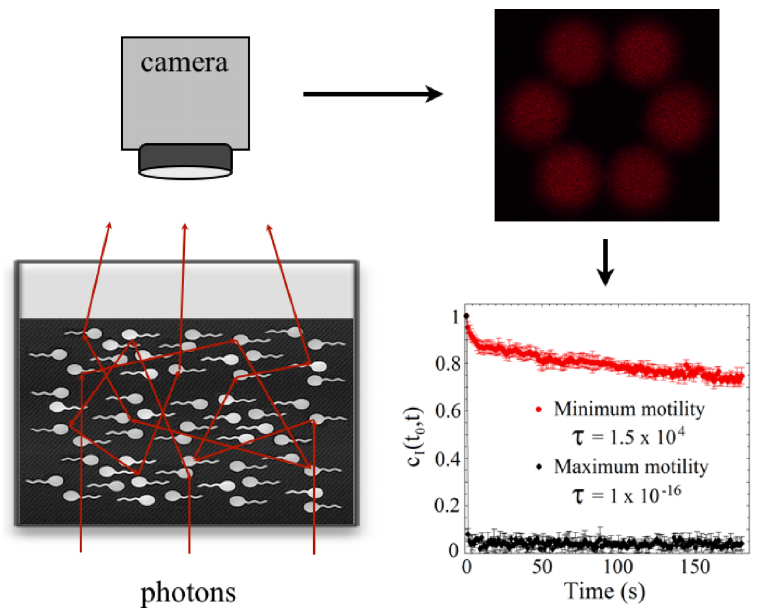
Figure 1. Schematic drawing of the cell motility sensor. A beam of a He-Ne laser is optically driven to a chamber that contains a sample holder. This sample holder has six small holes that can be filled with the sample. Light passes through each one of these receptacles. The scattering pattern is recorded by a digital camera for Image Correlation Analysis. See details in [26].